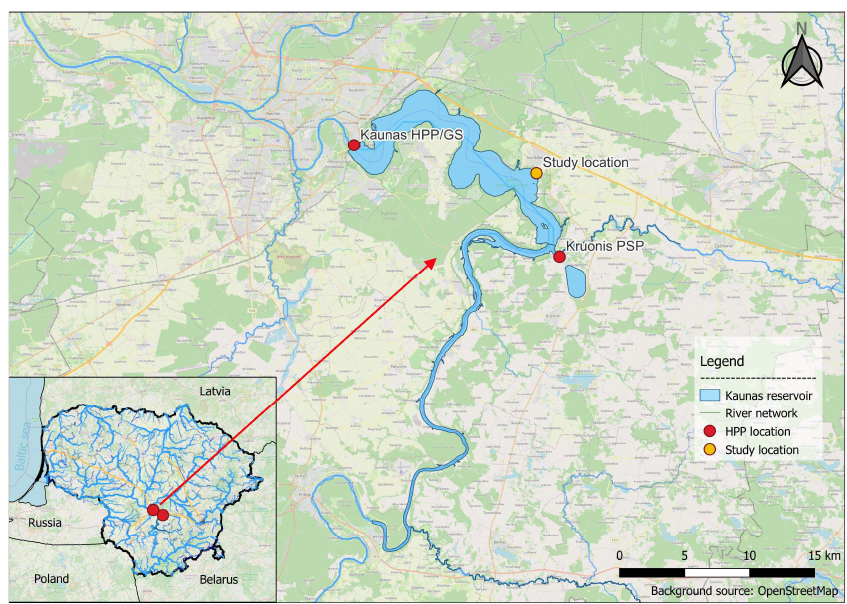
Figure 1. Map of the reservoir of the Kaunas Hydropower Plant.